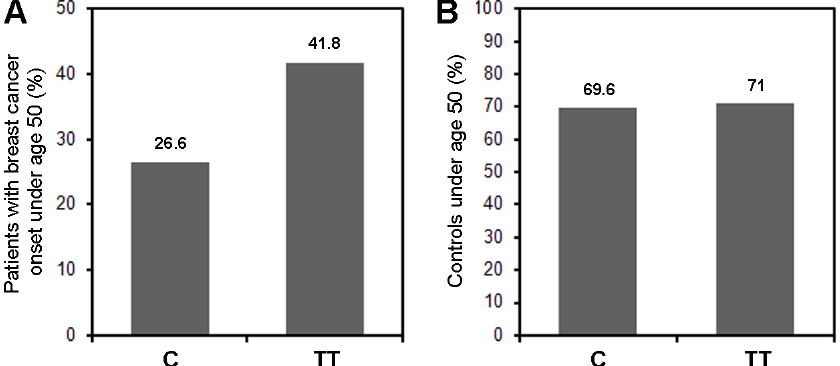
Figure 1. Breast cancer patients with the TT genotype exhibit an increased frequency of early onset. ( A ) percentage of breast cancer patients under the age of 50 with the TT genotype (TT) vs . the CC or TC genotype (C-carriers, C). p = 0.018, Chi-square test; ( B ) controls under the age of 50 at the time of recruitment are shown for comparison ( p =